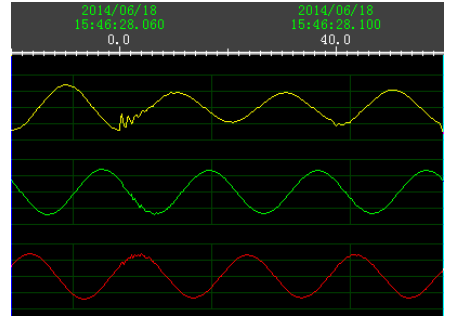
Figure 12. Waveform of three-phase voltages when AG fault occurred.